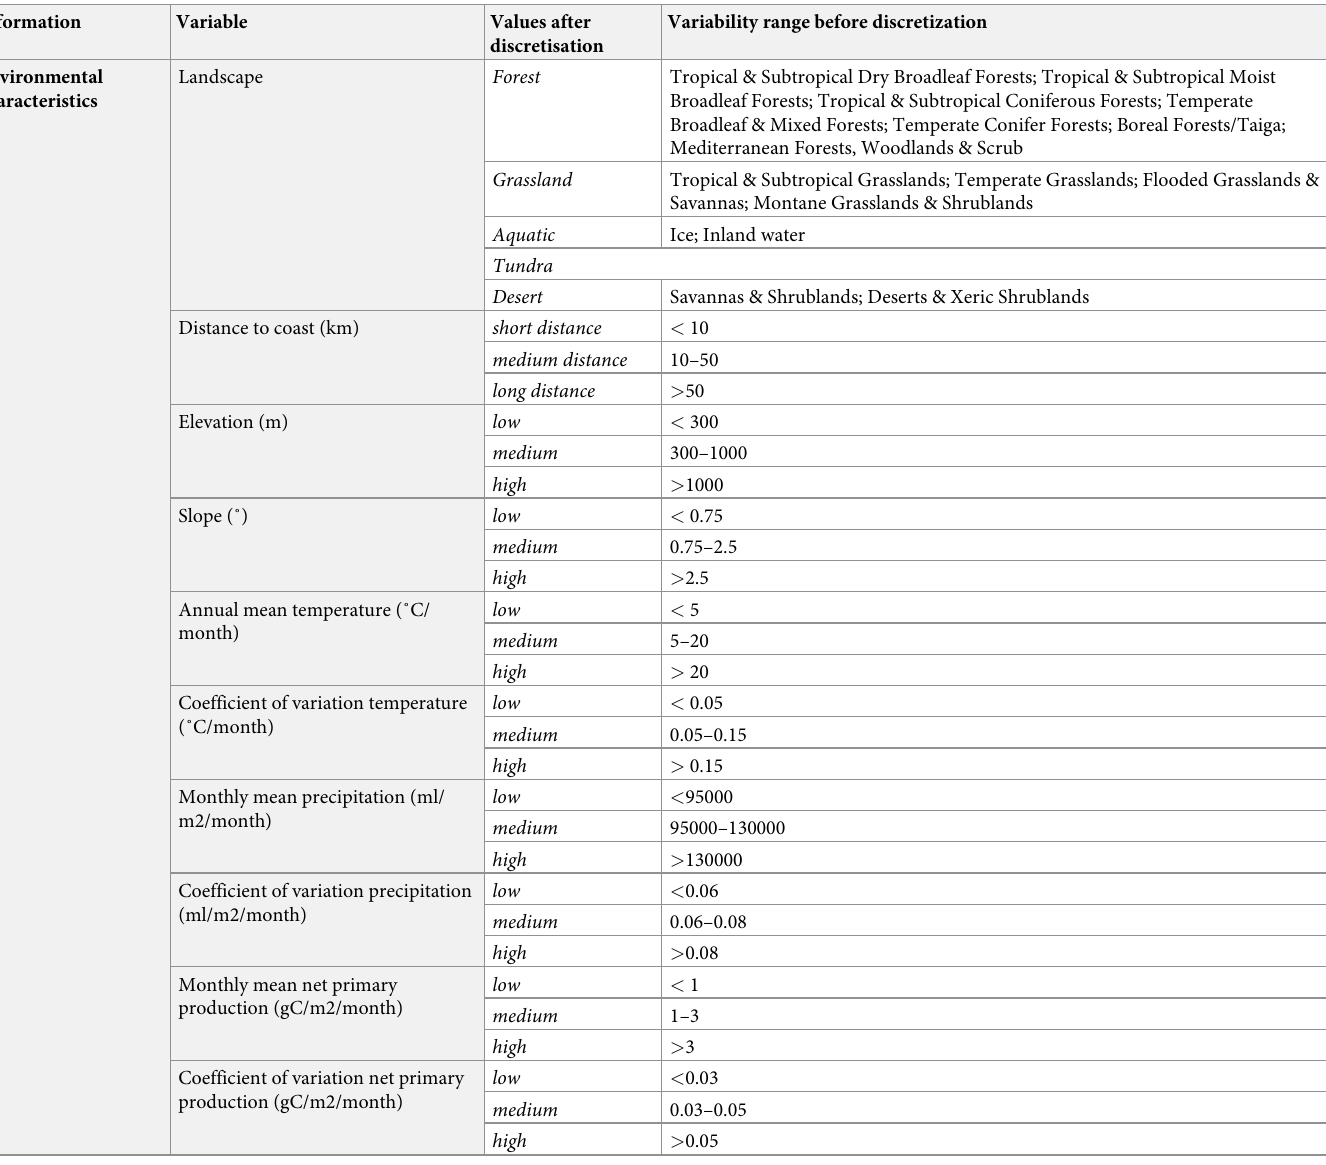
Table 2. Qualitative variables and their categorical values investigated in this research. It contains the 30 variables and their values. Ecological characteristics of settle- ment location and its catchment area are defined in nominal scales using integrative categories. Information Variable Values after discretisation Environmental